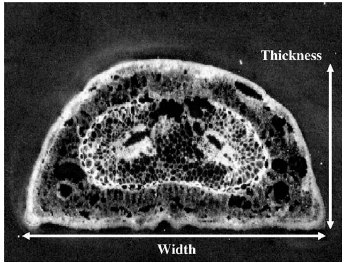
Figure 5. Photomicrograph of Pinus banksiana needle cross sections. The source is Moorthy, Miller and Noland [6].